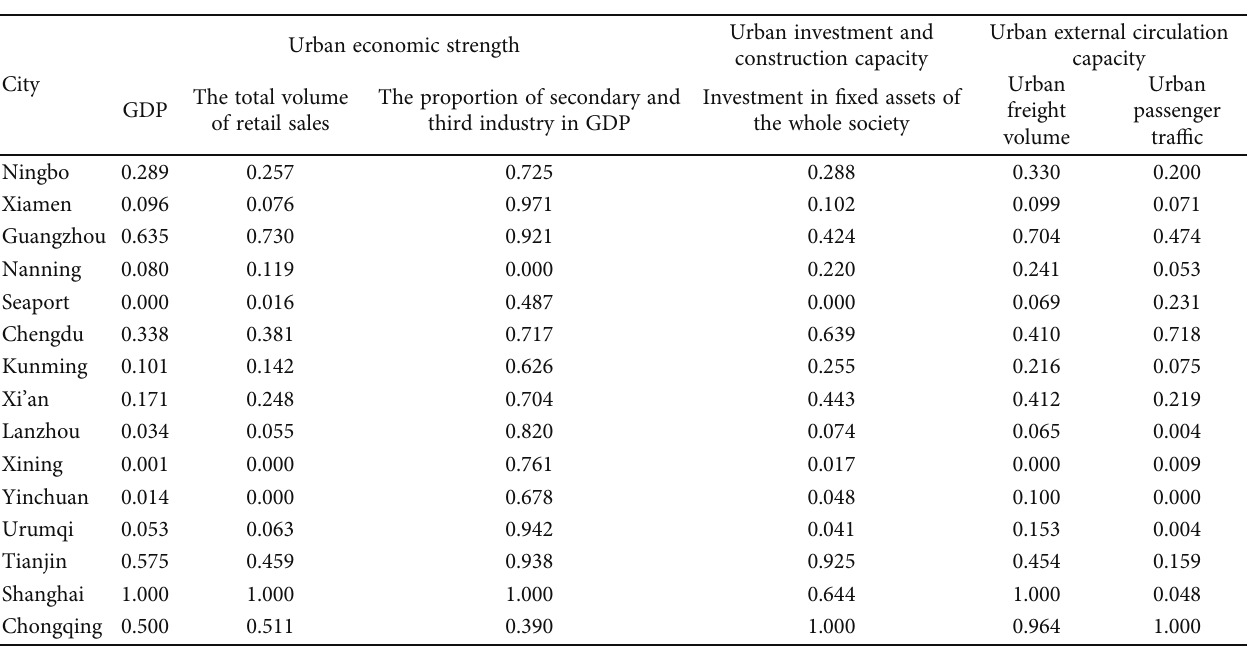
Table 2: Cluster analysis of raw